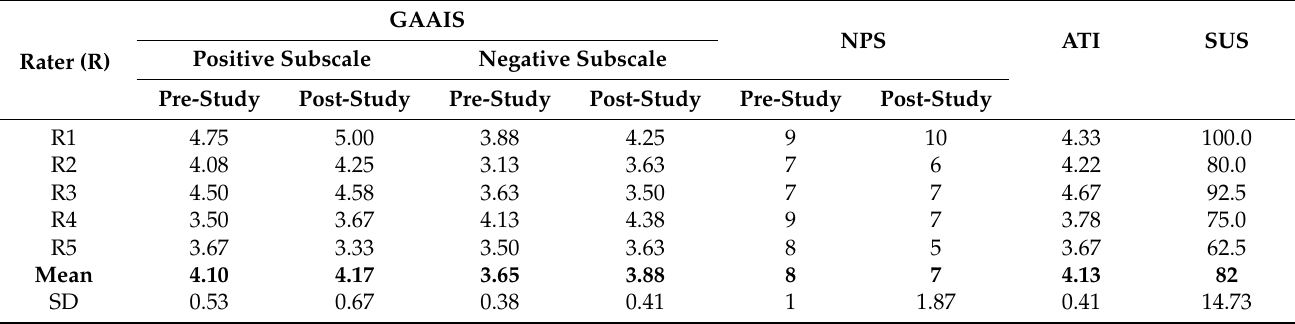
Table 4. GAAIS, ATI, and NPS scores of physicians according to respective study phase. GAAIS—general attitudes towards artificial intelligence scale; ATI—affinity for technology interaction (ATI) scale; NPS—net promoter score; SUS—system usability scale; SD—standard deviation.